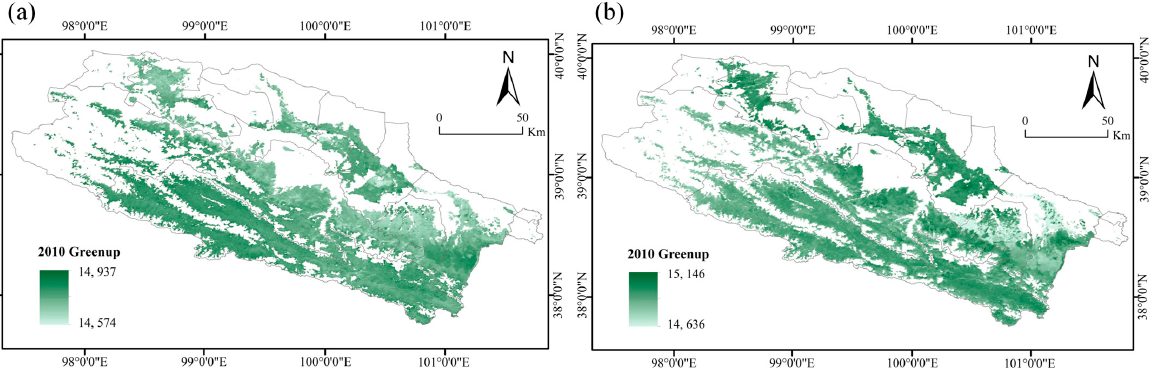
Figure 2. The spatial distribution of phenological variables Greenup ( a ) and Dormancy ( b ) in 2010. Note that values of the phenological variables represent accumulated days since 1 January 1970. Table 1. Information of environmental variables in the study area.